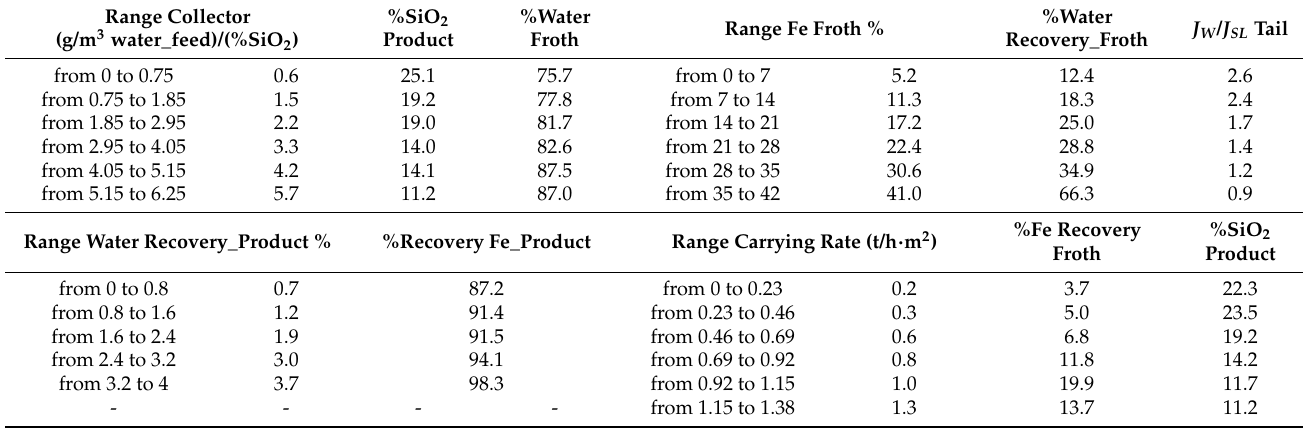
Table 7. Average values per range of variation of the collector, % Fe in the froth, J L _product and carrying rate. Range Collector %SiO 2 Product (g/m 3 water_feed)/(%SiO 2 )